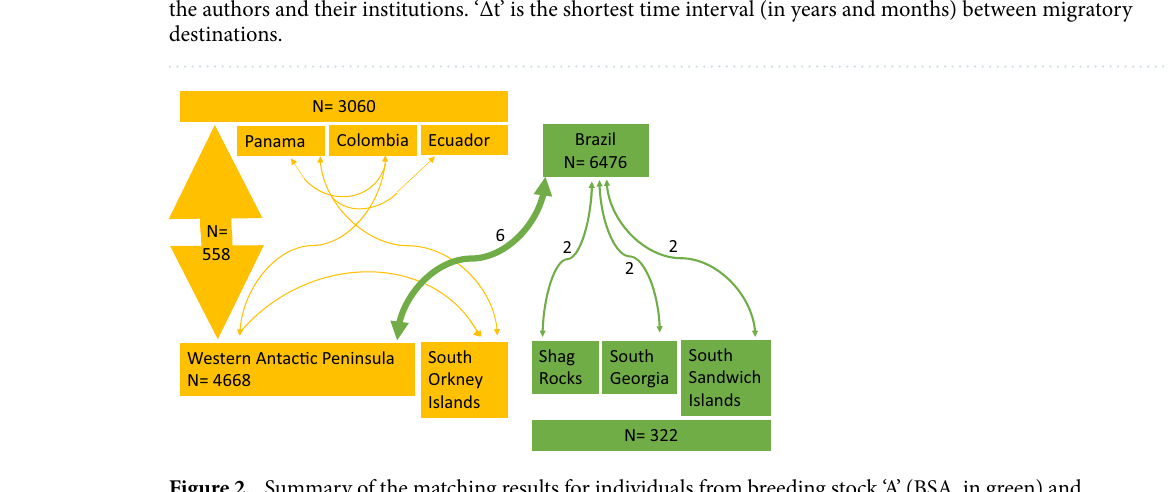
Figure 2. Summary of the matching results for individuals from breeding stock ‘A’ (BSA, in green) and breeding stock ‘G’ (BSG, in orange). N indicates the number of individual whales in the Happywhale catalogue from each region (N for Brazil is likely overestimated because all catalogues have not yet been cross-validated). The thickness of the arrows indicate the number of matched individuals (excepting the arrow linking the west coasts of Central and South America to the Western Antarctic Peninsula, not to scale because it is much greater, N = 558). Two particular BSG humpback whales are shown moving between the WAP all the way to the edge of the putative feeding area for the Central and South American Pacific breeding population. The number of matched individuals is noted if greater than one by each arrow connecting breeding and feeding